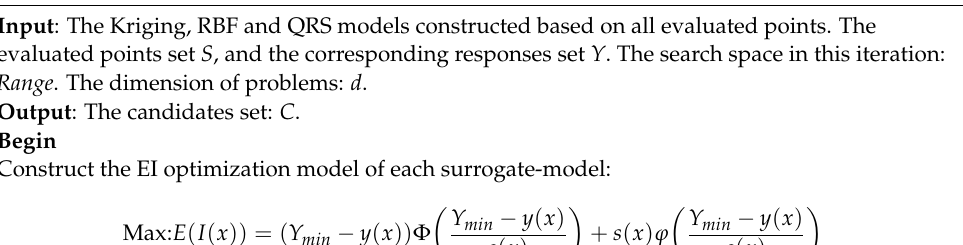
Algorithm 1 (Pseudocode) Multimodal EI criterion